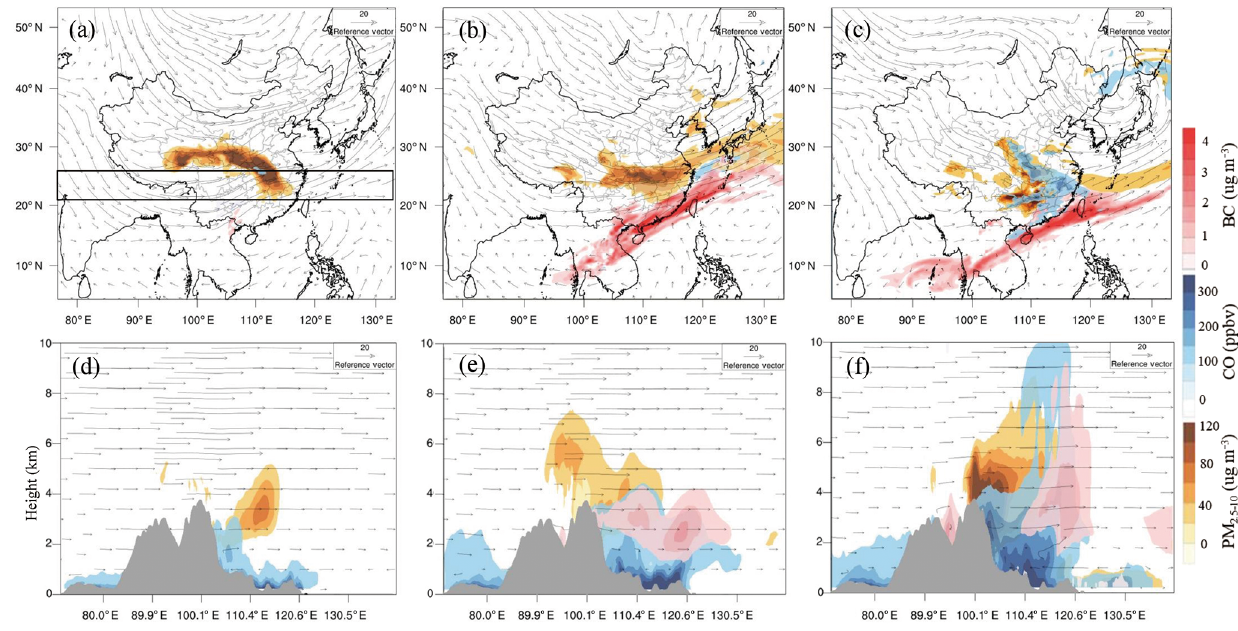
Figure 10. WRF-Chem-simulated mixed pollutants from dust (PM 2 . 5–10 ), anthropogenic emissions (CO) and BB (BC) at 5km in altitude and vertical cross sections of mixed pollutants averaged from the area in the black box in Fig. 10a at 08:00LT on (a, d) 19 March, (b, e) 21 March and (c, f) 23